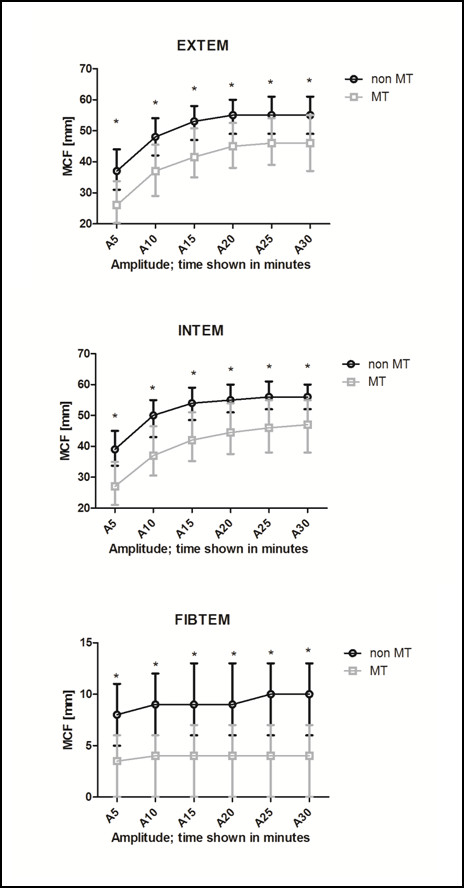
ROTEM® measurements differed between patients who received massive transfusion and those that did not. Clot amplitude of EXTEM, INTEM and FIBTEM in five minute intervals for patients who received or did not receive massive transfusion. For each test, after 10 minutes, 75 to 90% of the entire MCF is reached. A5 to A30, amplitude at five-minute intervals; EXTEM, extrinsically activated thromboelastometric test; FIBTEM, extrinsically activated thromboelastometric test with cytochalasin D; INTEM, intrinsically activated thromboelastometric test; MCF, maximum clot firmness; MT, massive transfusion. Groups were compared using the Kruskal-Wallis test. * P < 0.0001 between groups.